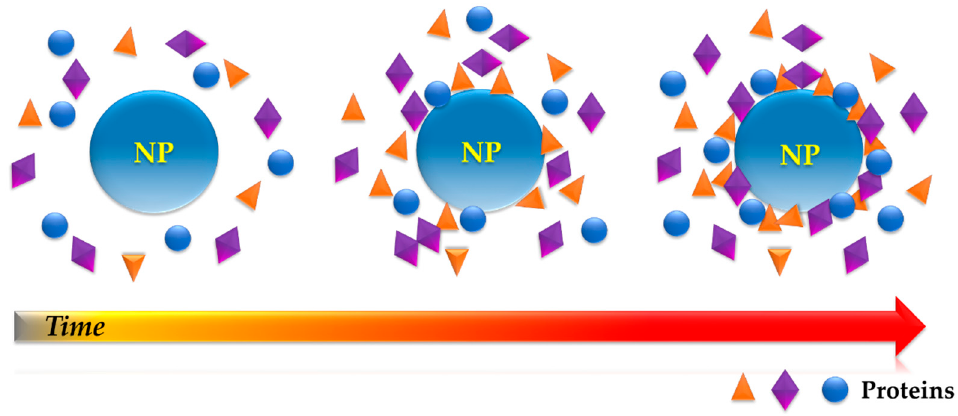
Figure 1. Protein adsorption onto a nanoparticle (NP) overtime leading to the formation of the so-called “protein corona” (cross-section view).